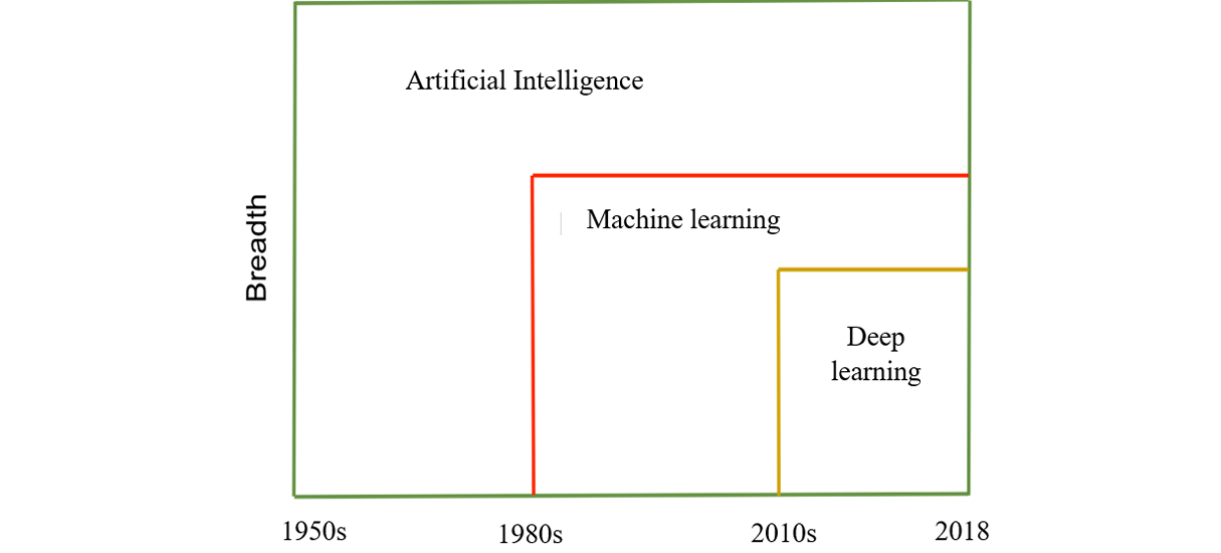
Figure 3. Relationship between artificial intelligence, machine learning and deep learning with emerging